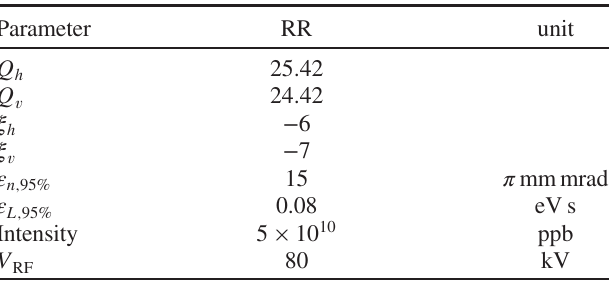
TABLE I. Typical Recycler properties for beam sent to NuMI with an average power of 700 kW.